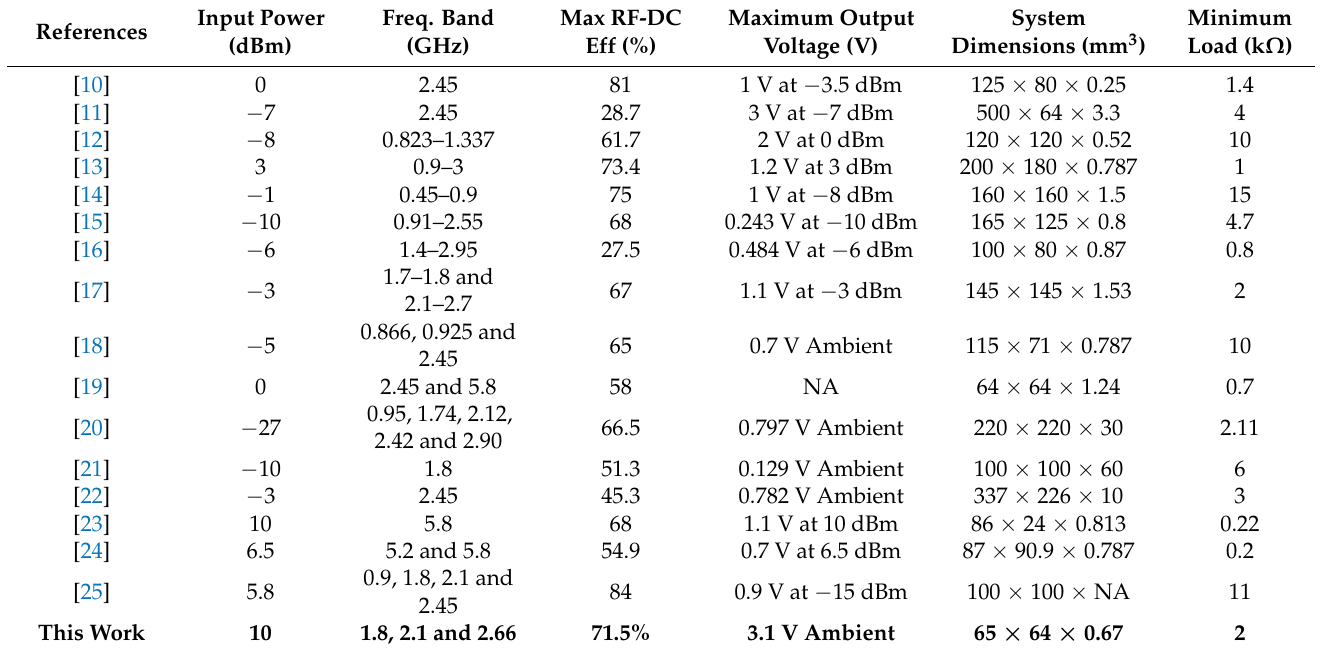
Table 7. Comparison between proposed RF-EH system performances and other systems reported in the